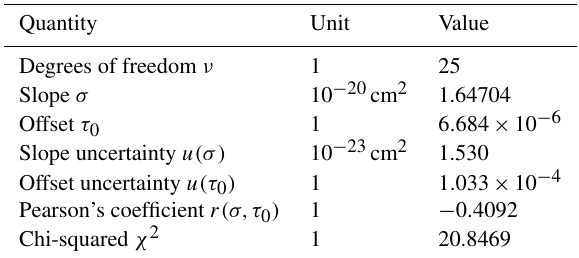
Table 4. Linear fit statistics including standard uncertainty ( k = 1) values.